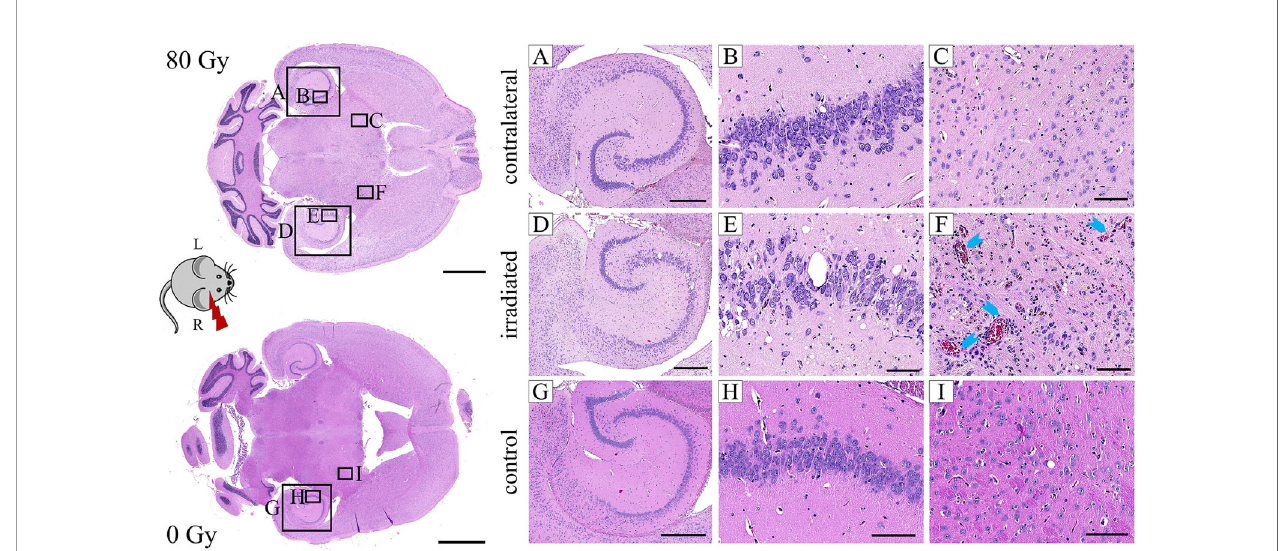
FIGURE 8 | Exemplary H&E images of an 80 Gy proton irradiated (A – F) or control (G – I) C3H/He brain. The right hemisphere was exposed to proton radiation; the left hippocampus received no dose. Microfocal edema (D – F) , vessel proliferation (D – F) , hyalinosis and dilatation ( F , blue arrows) of vessels, incomplete necrosis (D – F) , siderophages ( F , brown color), and white matter damage (D – F) were noted in the irradiated brain. The hippocampus had a reduced cell density and granule cell dispersion (D, E) . None of these effects were present in the contralateral side (A – C) and the control animal (G – I) . Pink: parenchyma, violet: cell nuclei, red: erythrocytes, brown: siderophages. Scale bars (left to right): 2 mm, 500 µm, 100 µm, 100